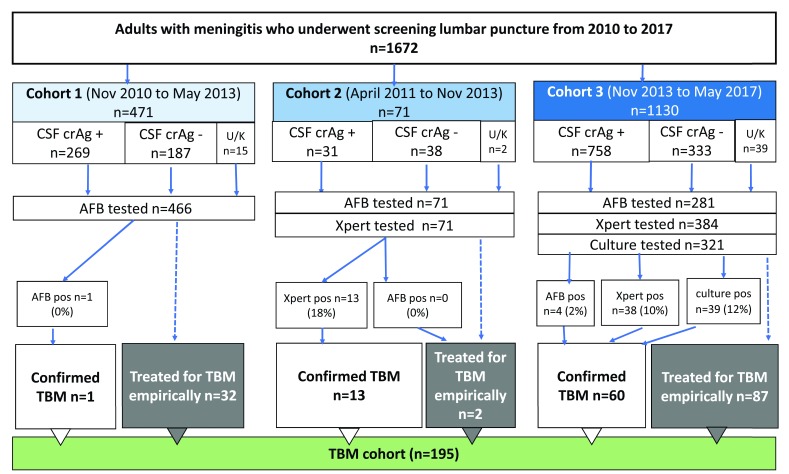
Illustration of flow of patients from the screening population into the TBM cohort.